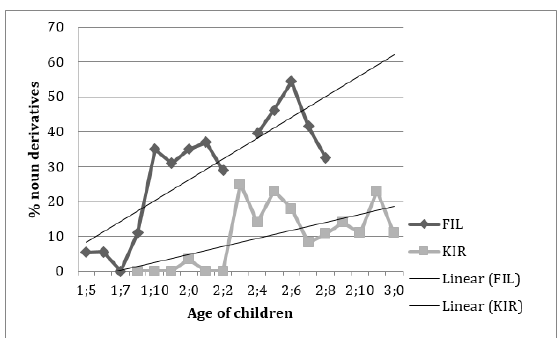
Figure 1. Distribution of